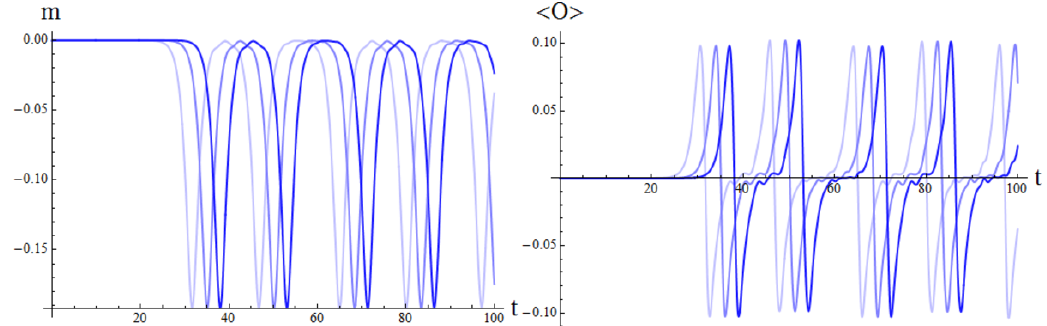
Figure 4 . Time evolution of the mass (left) and vev (right) for the oscillatory solution with (cid:11) o = 2 : 71. The coloring encodes the three spatial resolutions N = 2 10 , 2 11 , 2 12 employed to build the initial data and perform the simulation. Consistently, the transition to a time-dependent solution happens at later times for increasing N . On the contrary, the periodicity is resolution-independent. This means that the system reaches the same limiting cycle at di(cid:11)erent times depending on the initial conditions.